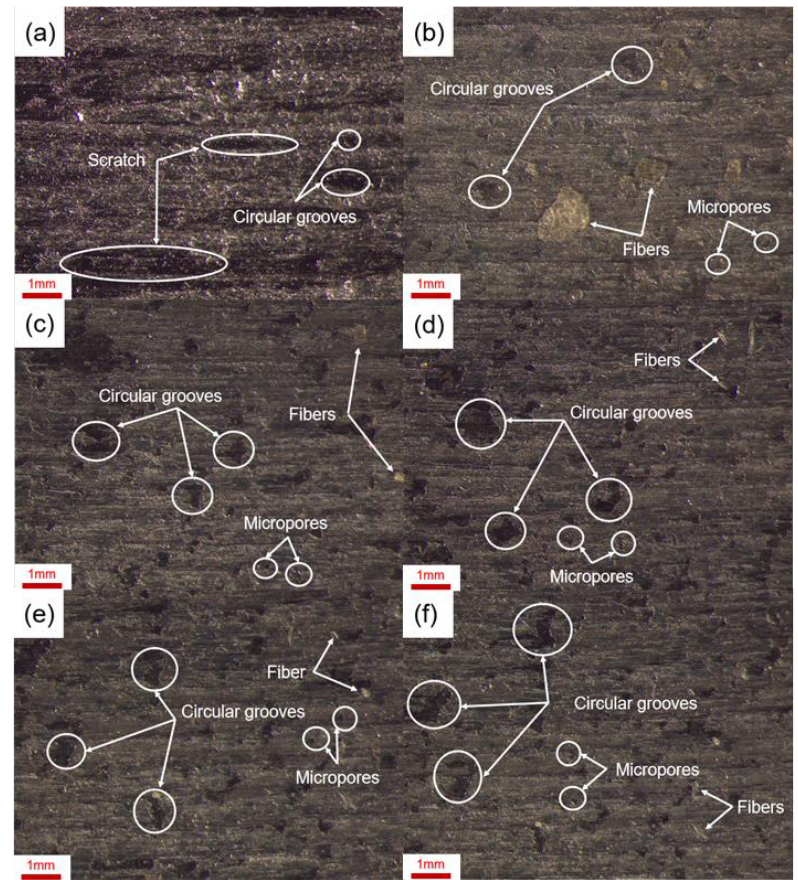
Figure 9. Worn disk surfaces with various particle sizes under lubricating oil condition: ( a ) no powder added; ( b ) 0.17 mm; ( c ) 0.28 mm; ( d ) 0.43 mm; ( e ) 0.56 mm; ( f ) 0.90 mm.